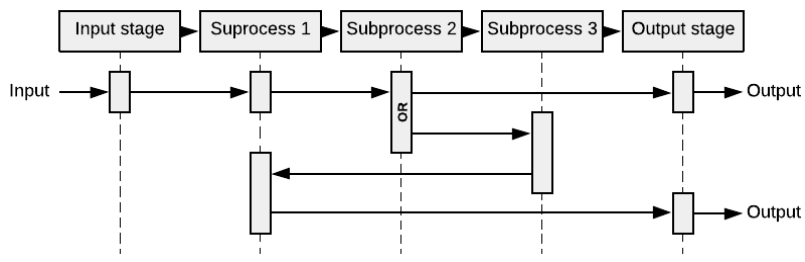
Figure 6. Simple illustration of a sequence diagram progressing through three subprocesses.